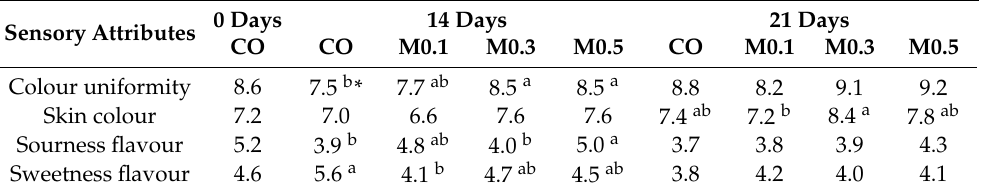
Table 2. Mean scores obtained in the sensory evaluation of ‘Samba’ cherries in relation to treatments and storage